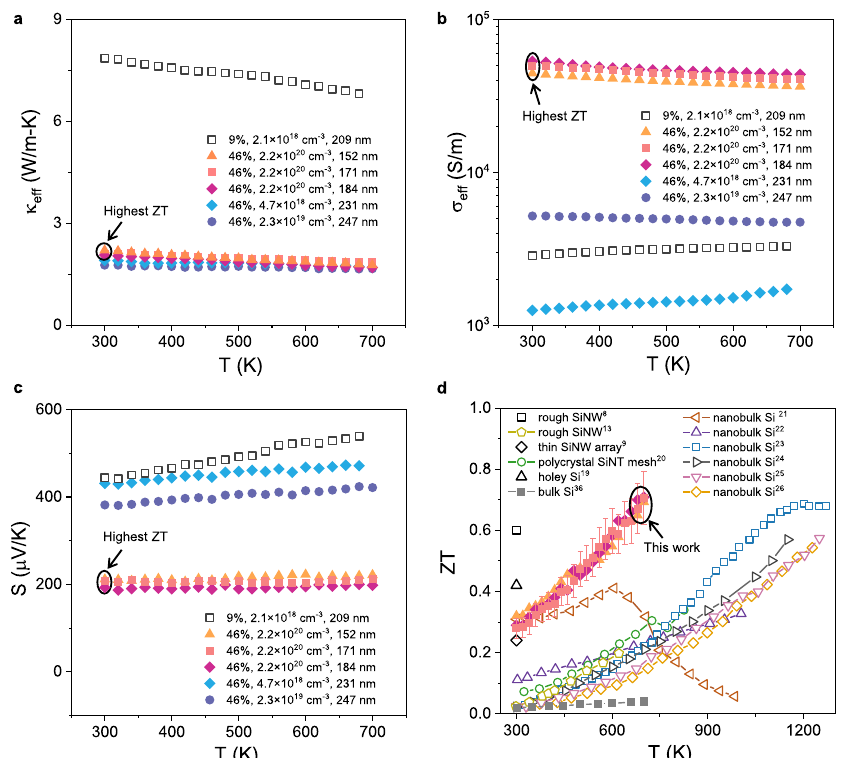
Fig. 2 Temperature-dependent thermoelectric properties. Measured a effective thermal conductivity, κ eff , b effective electrical conductivity, σ eff , and c Seebeck coef fi cient, S , of various porous SiNWs as a function of temperature. For the legend, the fi rst number represents SiNW porosity, the middle one is boron doping concentration ( p ) measured using secondary ion mass spectrometry (SIMS, see Methods), and the last number is SiNW diameter. Note κ σ eff and eff are extracted based on nanowire diameter without normalizing with porosity. d Calculated thermoelectric samples with ϕ = 46% and p = 2.2 × 10 20 cm − 3 (152, 171, 184 nm) with the highest ZT in this work, where the previously measured ZT results of single rough SiNW 8,13 , thin SiNW array 9 , polycrystalline Si nanotube mesh 20 , holey Si 19 , nanobulk Si 21 – 26 and bulk Si (8.1 × 10 19 cm − 3 boron-doped) 36 are plotted for comparison. The error bars represent ZT uncertainties calculated based on measurement errors in κ , σ , and S (see Supplementary Note